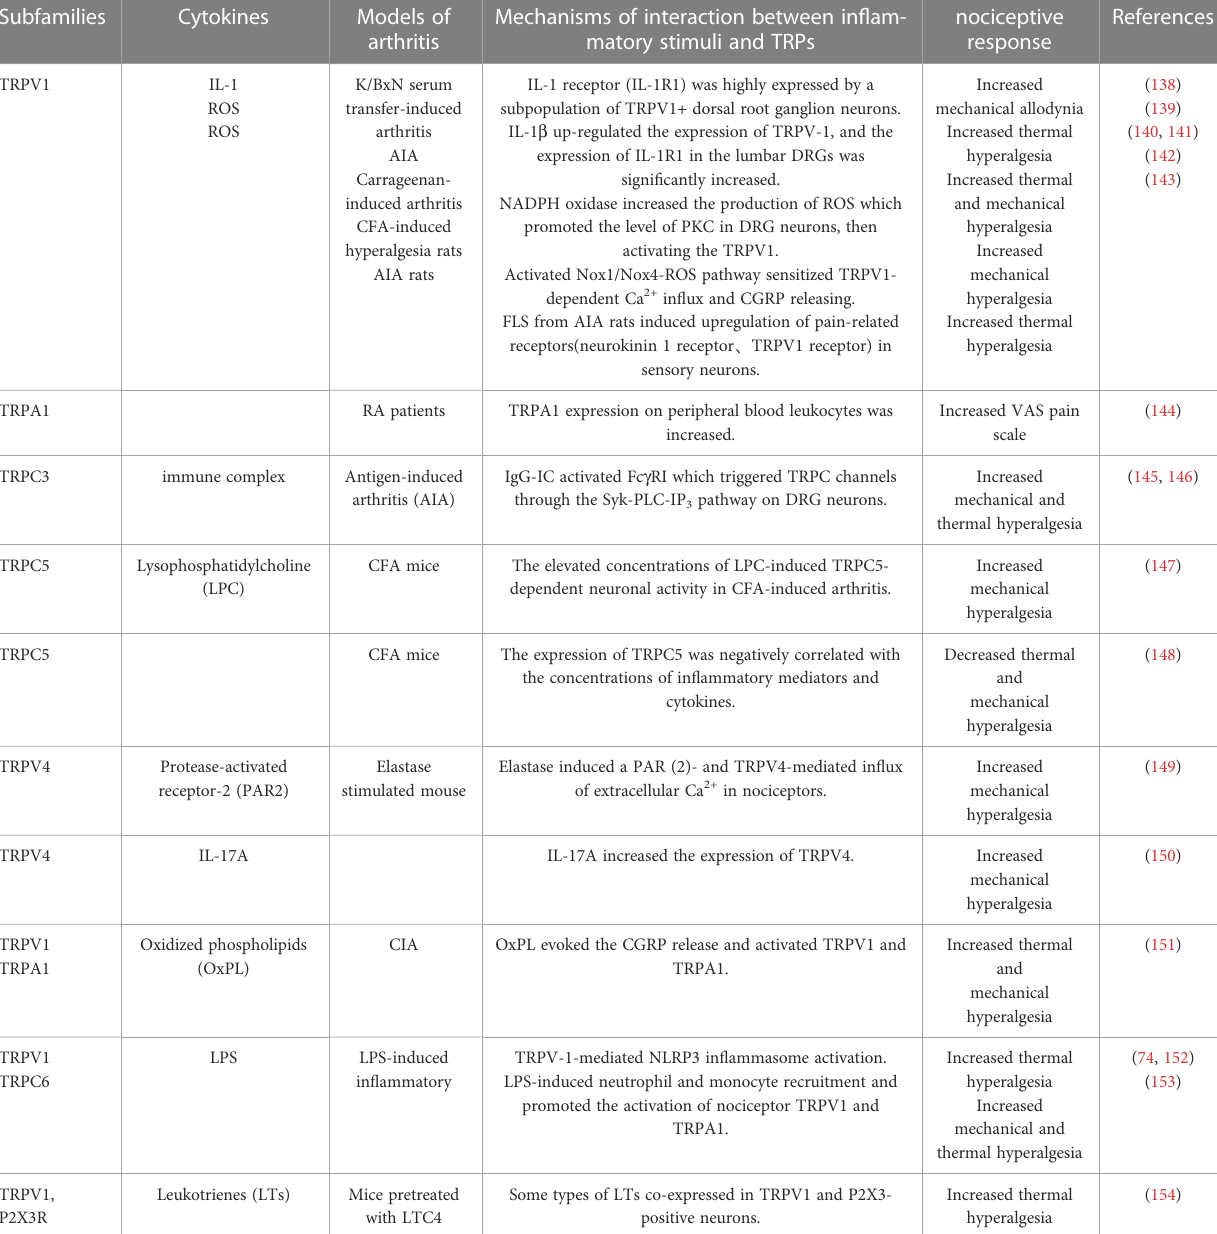
TABLE 1 Summary of RA related in fl ammatory stimuli on different subtypes of TRPs in in fl ammatory pain perception. Subfamilies Cytokines Models of